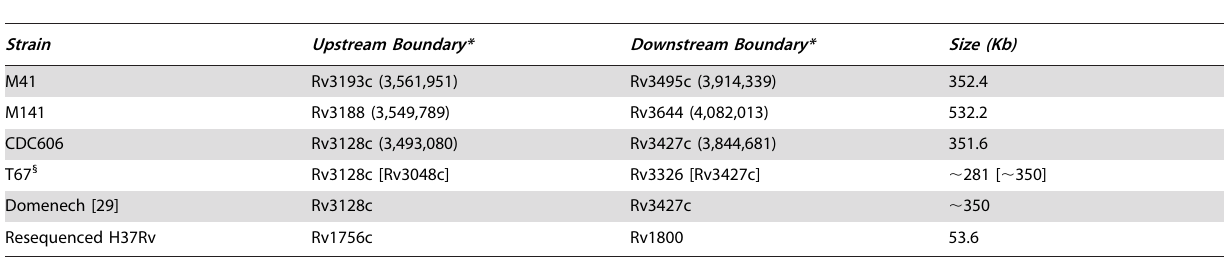
Table 2. Summary of Large Scale Duplication